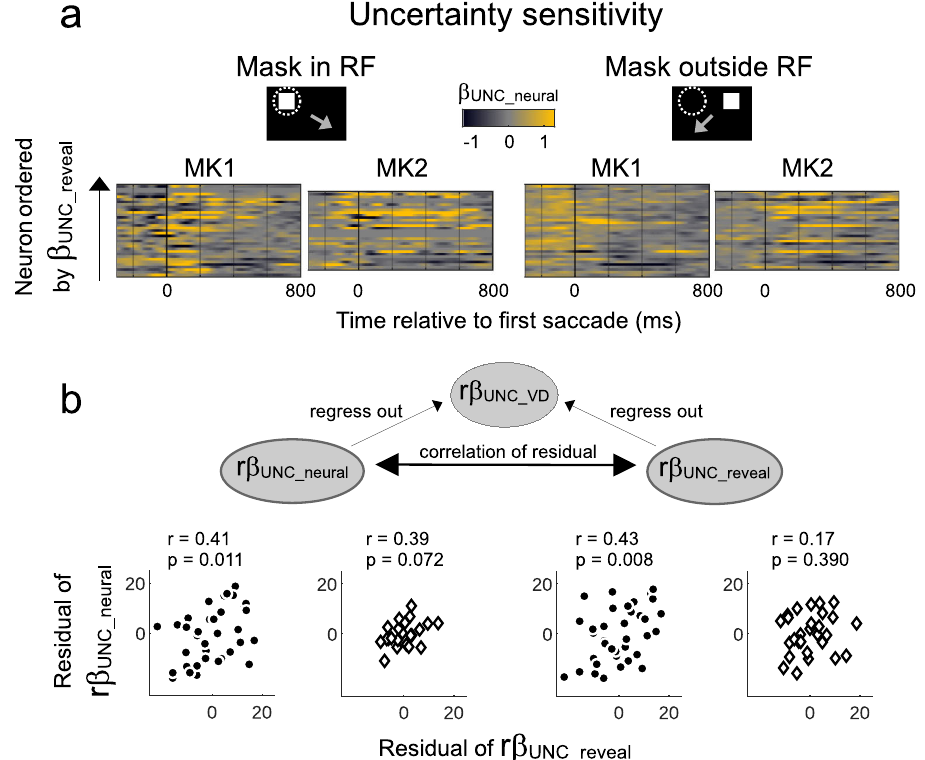
Fig. 4 | Correlations between neuraland behavioralsensitivityto uncertainty. a Color maps of the time-resolved β UNC_neural coef fi cients (color) for individual neurons ordered according to the magnitude of the uncertainty coef fi cient in revealingbehavior( β UNC_reveal ).Theanalysiswasperformedontrialswhenthemask wasinsidetheRF(left)oroutsidetheRF(right)butthesaccadewasawayfromthe mask(cartoons). b Top:thepartialcorrelationanalysiscontrollingforcorrelations between the effects of uncertainty on viewing duration (VD) and reveal behavior. Raw β UNC_reveal coef fi cientsand β UNC_neural averagedover200-600msaftersaccade onsetweretransformed toranked values( r β )and separatelyregressedagainstthe